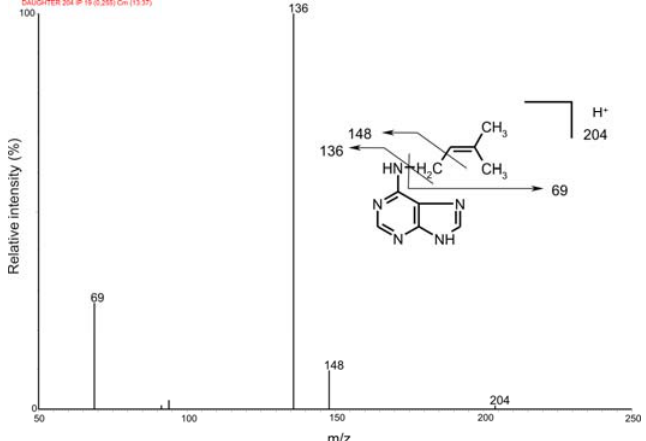
Figure 2. Collision mass spectrum of isopentenyladenine and its fragmentation pattern.